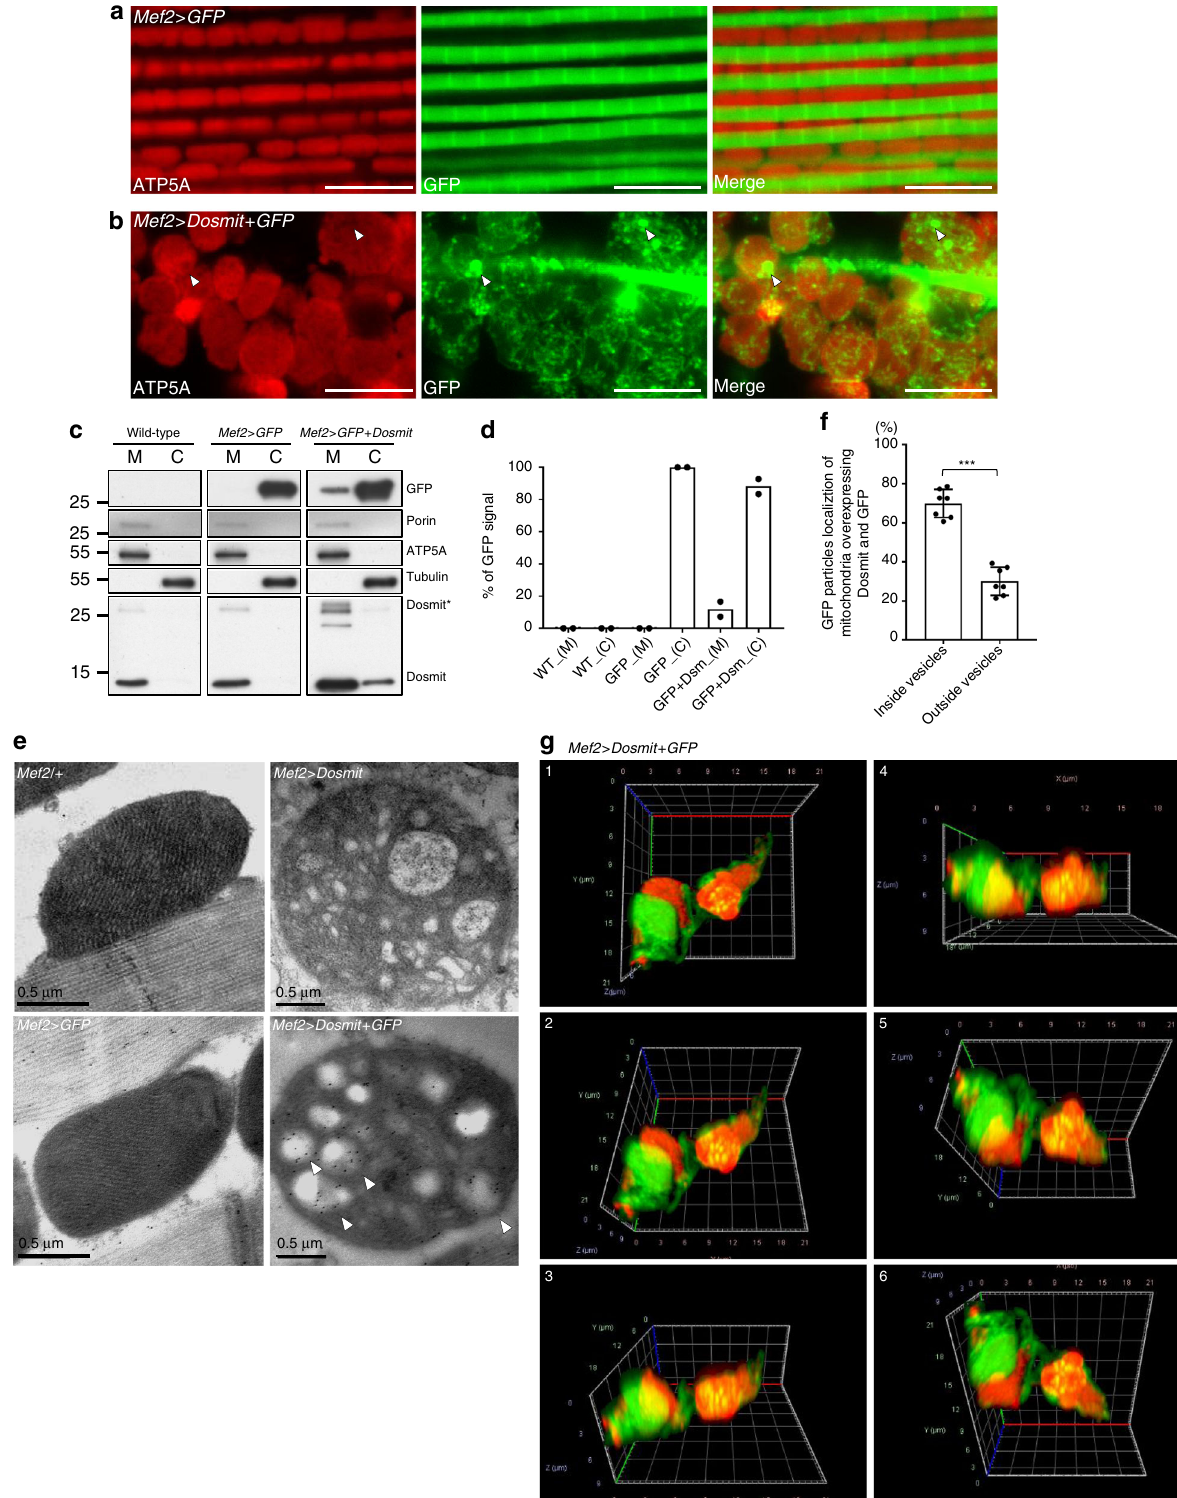
(Fig. 8e), and Rab32-HA protein but not Hsc70-5-HA in the Dosmit-associated complex that was pulled down by the Dosmit antibody (Fig. 8f). This indicates that Dosmit and Rab32 form a protein complex.